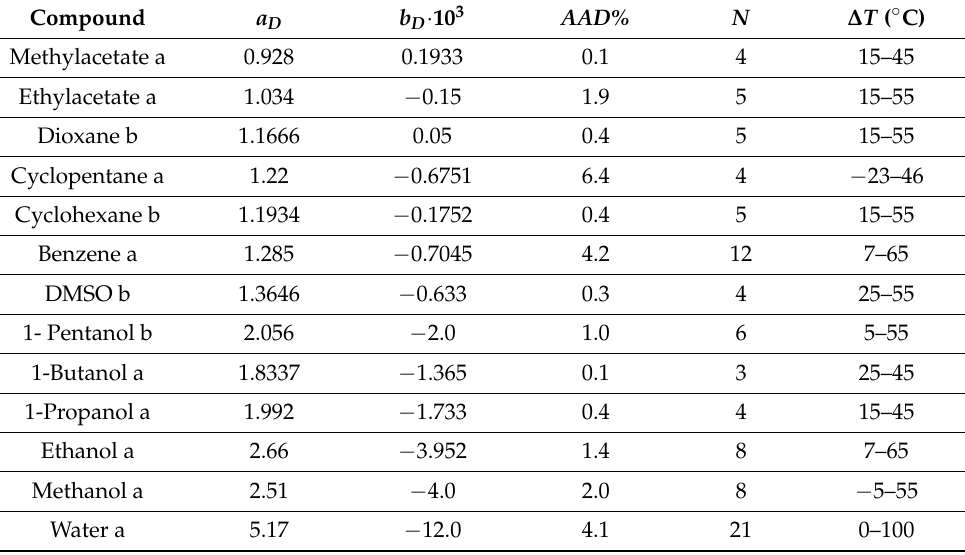
Table 3. The a D and b D values for the factor f D in Equation (25) and the AAD% values for N measured D D -values in the temperature range ∆ T [34] b , [35] a for 13